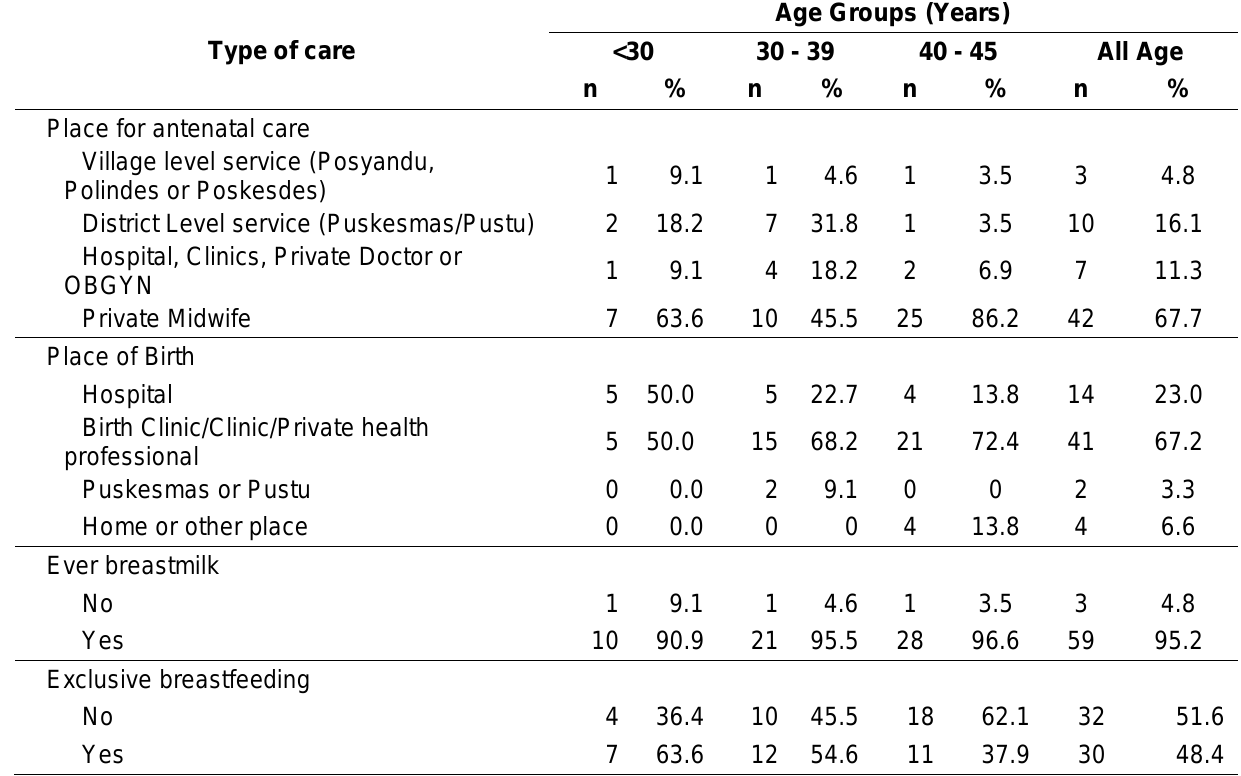
Table 3. Maternal and child health care-seeking behaviour for the last pregnancy in women aged 15 – 45 years